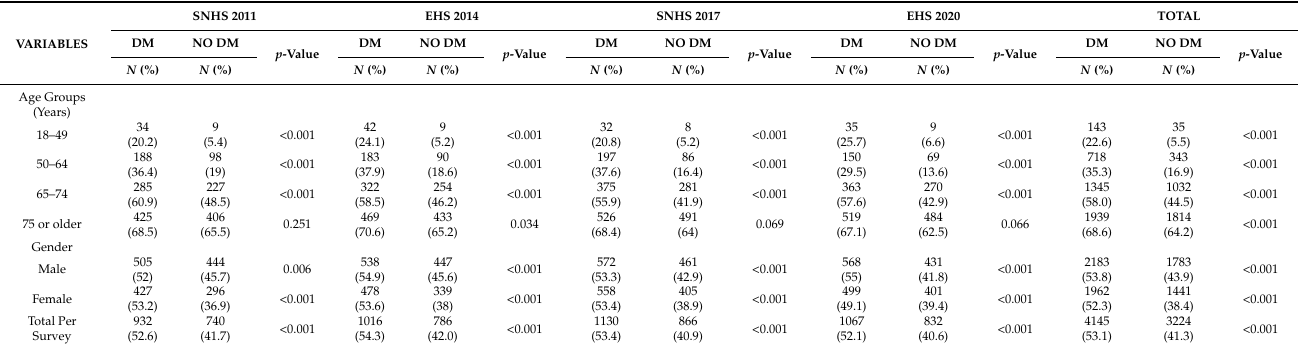
Table 1. Vaccine uptake across the surveys according to age and